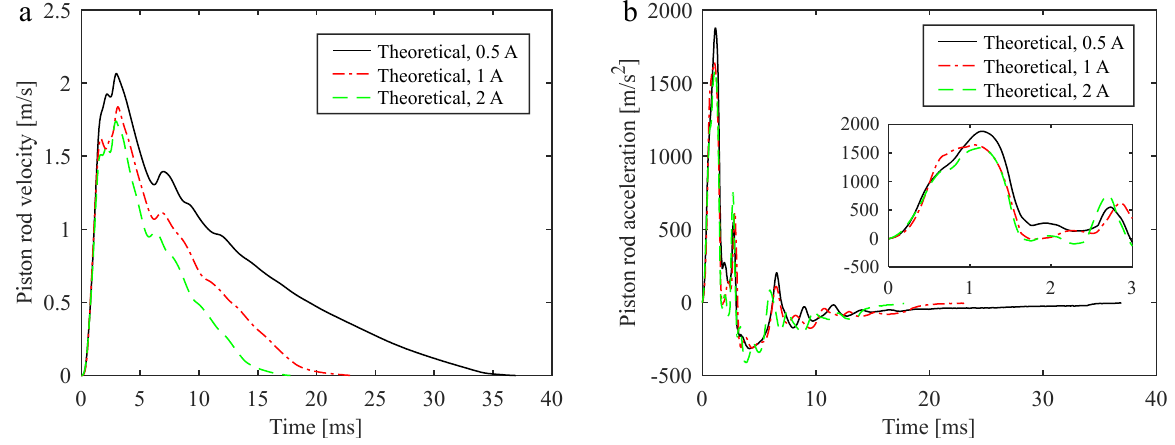
Figure 13. Theoretical values of piston rod velocity and acceleration for different excitation currents.